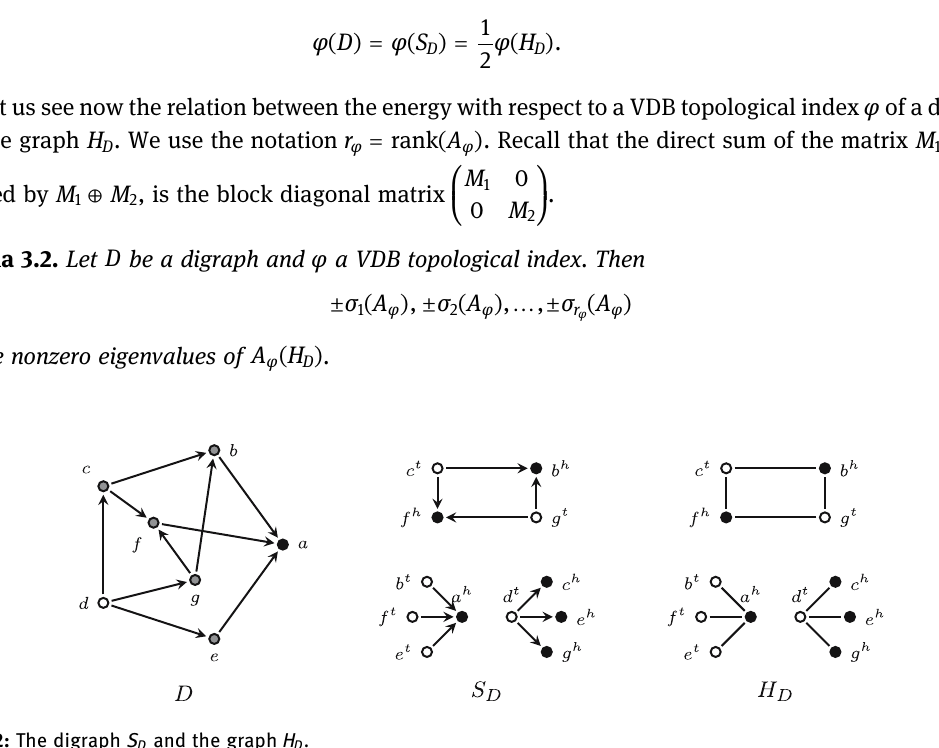
Figure 2: The digraph S D and the graph H D